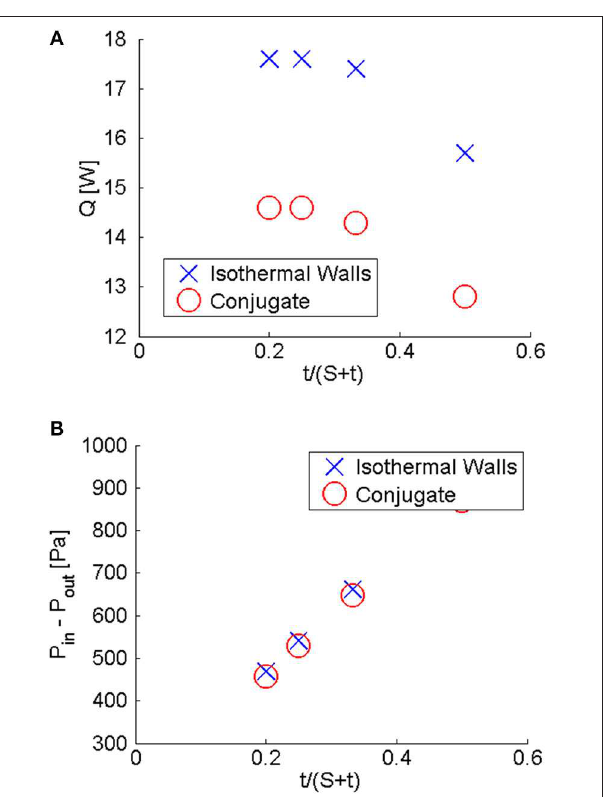
FIGURE 8 | Effects of S/H on heat-transfer rate (Q) and pressure drop